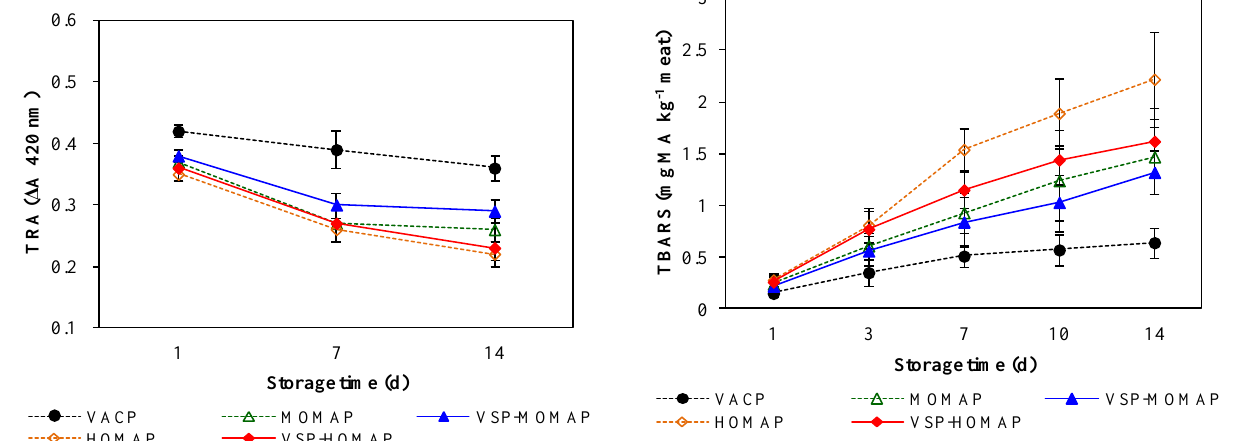
Figure 2. Total reducing ability (TRA) in sliced Hanwoo (Korean cattle) beef loin in packaging systems for 14 d at 4°C. Data are presented as means±SD. VACP, vacuum packaging; MOMAP, medium oxygen-modified atmosphere packaging (50% O 2 /20% CO 2 /30% N 2 ) alone; VSP-MOMAP, MOMAP combined with vacuum skin packaging; HOMAP, high oxygen-MAP (80% O 2 /20% CO 2 /0% N 2 ) alone; VSP-HOMAP: HOMAP combined with VSP; SD, standard deviation.